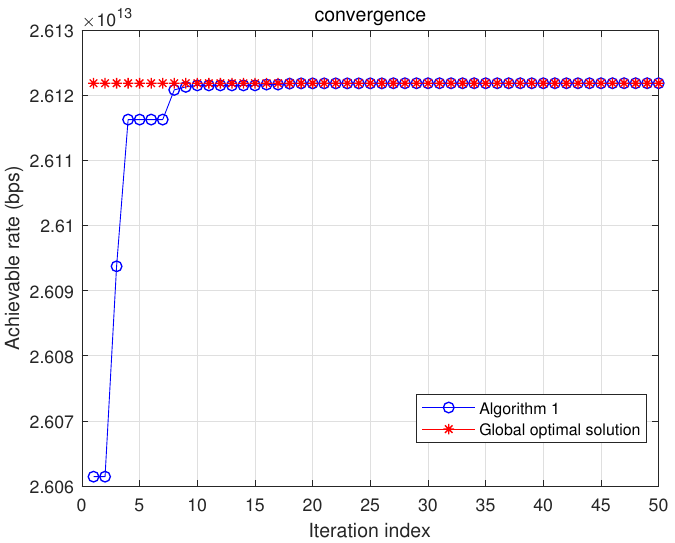
Figure 3. The convergence curve of Algorithm 1 and performance comparison between the proposed and exhaustive search methods.